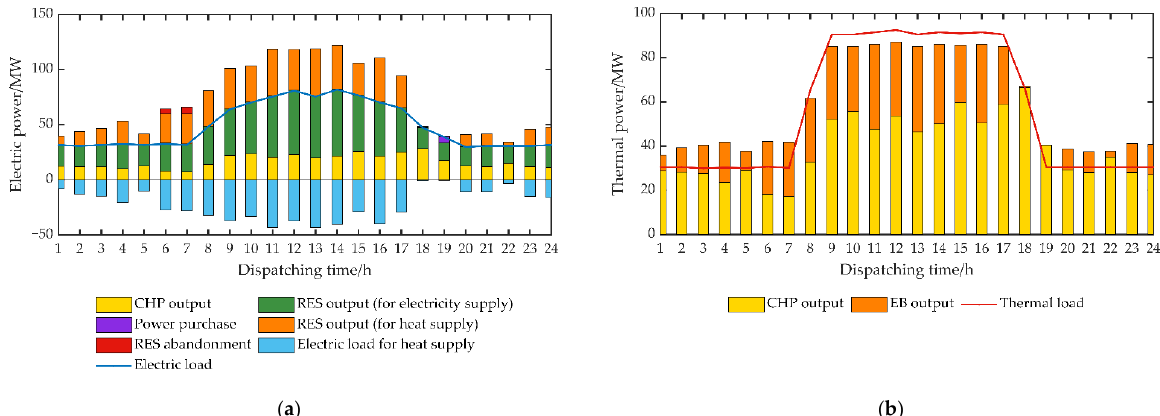
Figure 10. Independent dispatching in the industrial area: ( a ) Electric power; ( b ) Thermal power.